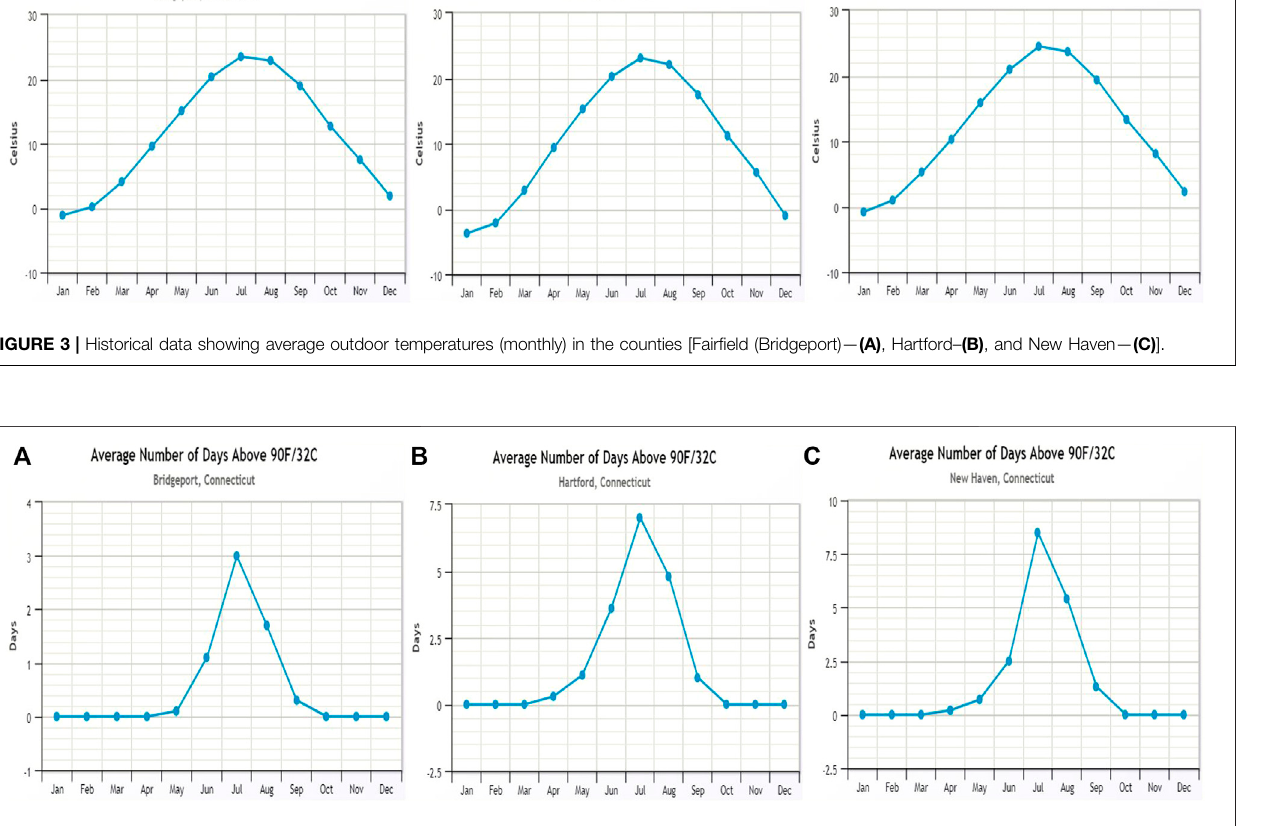
FIGURE 4 | Historical data showing the average number of days above 32 ° C (monthly) in the counties [Fair fi eld (Bridgeport) — (A) , Hartford — (B) , and New Haven — (C) ].